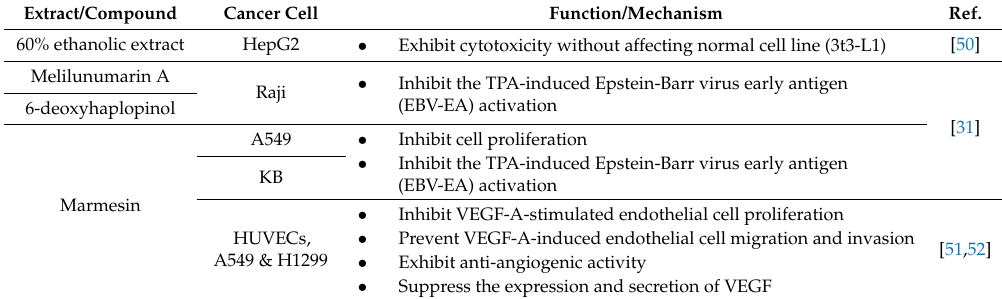
Table 4. Brief description of functions or mechanisms of extracts and compounds isolated from M. lunu-ankenda